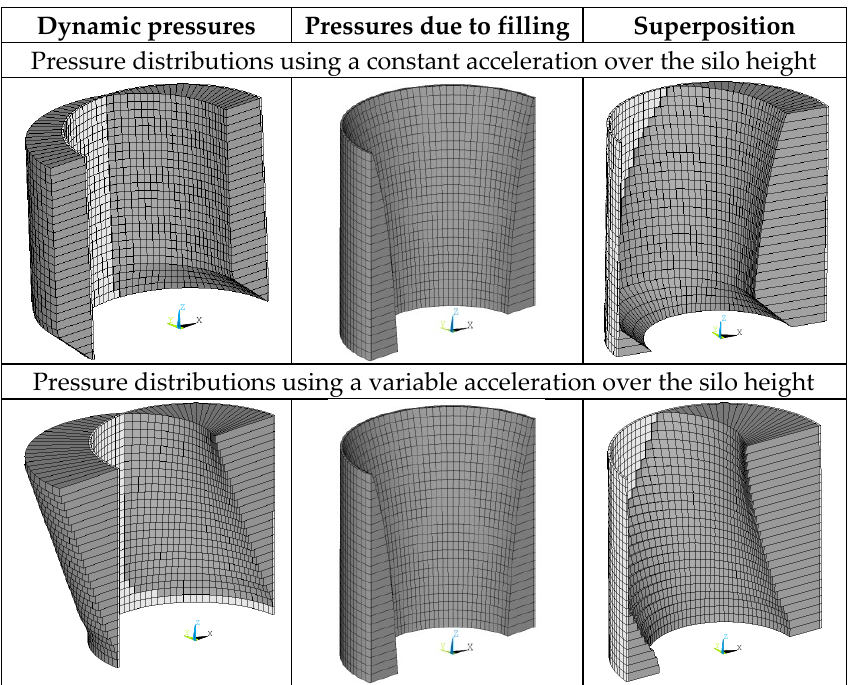
Figure 3. Pressure distributions—dynamic pressures, pressures due to filling and superposition.